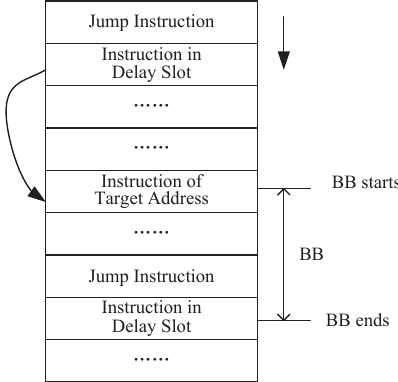
Figure 1. The basic block